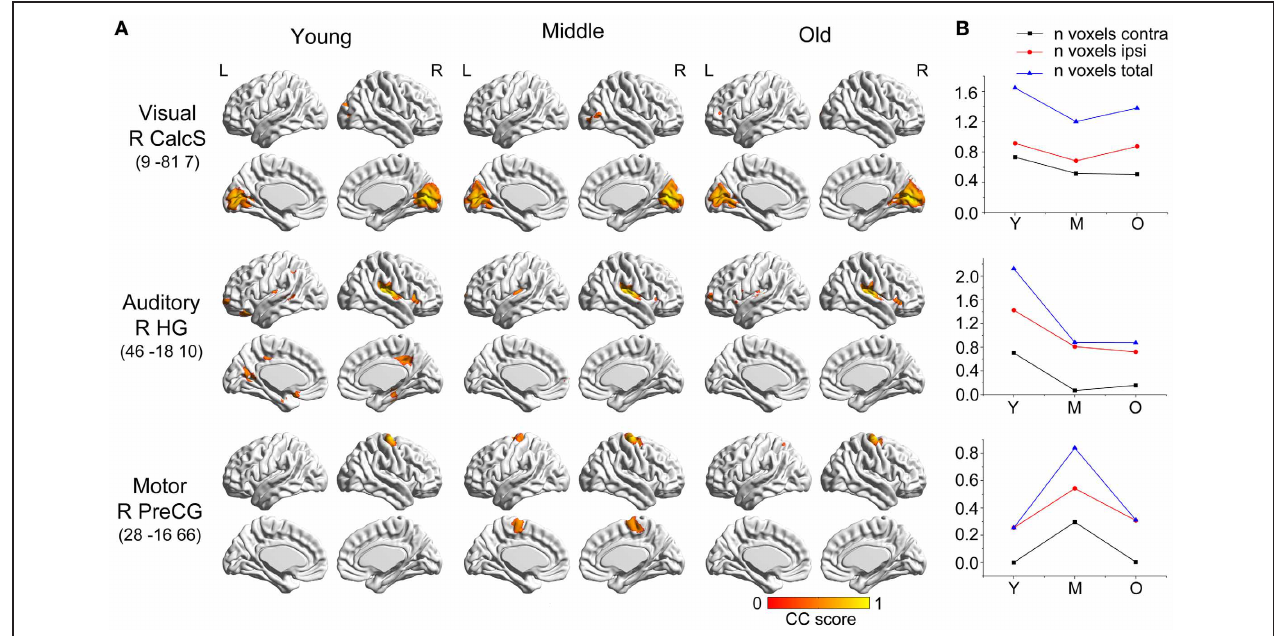
group indicate small covariance changes throughout the life-span. The y-axis represents the voxel number ( × 10 4 ). Abbreviations: Calcs, calcarine sulcus; HG, Heschl’s gyrus; PreCG, precentral gyrus; R, right; L, left; Y, young group; M, middle-aged group; O, old group; CC, correlation coefficient.